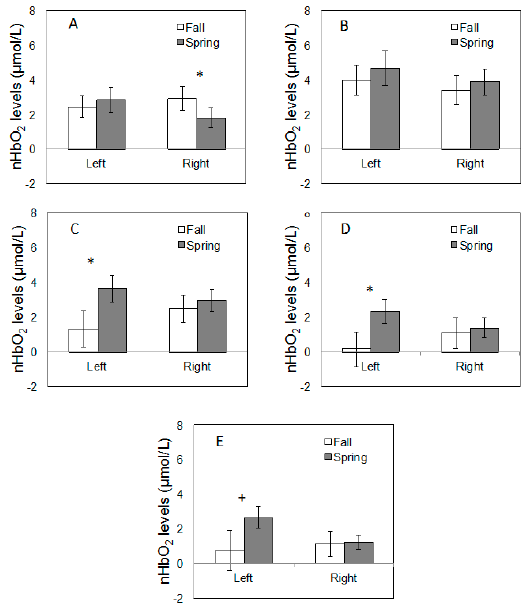
Figure 2. Right and left prefrontal cortex activation (nHbO 2 values) during the neurocognitive tests (( A ) Wisconsin Card Sort; ( B ) Flanker; ( C) Memory Span; ( D ) Trail Making; ( E ) Stroop Color Word). The symbols * and + indicate significant ( p < 0.05) and marginally significant (0.1 > p > 0.05) interactions between test points (Fall vs. Spring) and hemisphere (left vs. right). Error bars represent standard error.